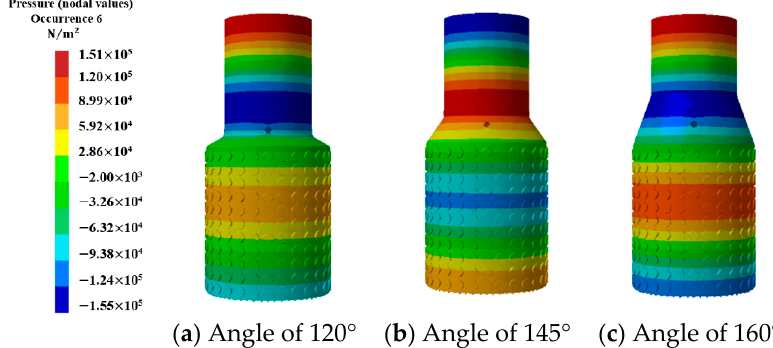
Figure 12. Fifth-order acoustic cavity modality.